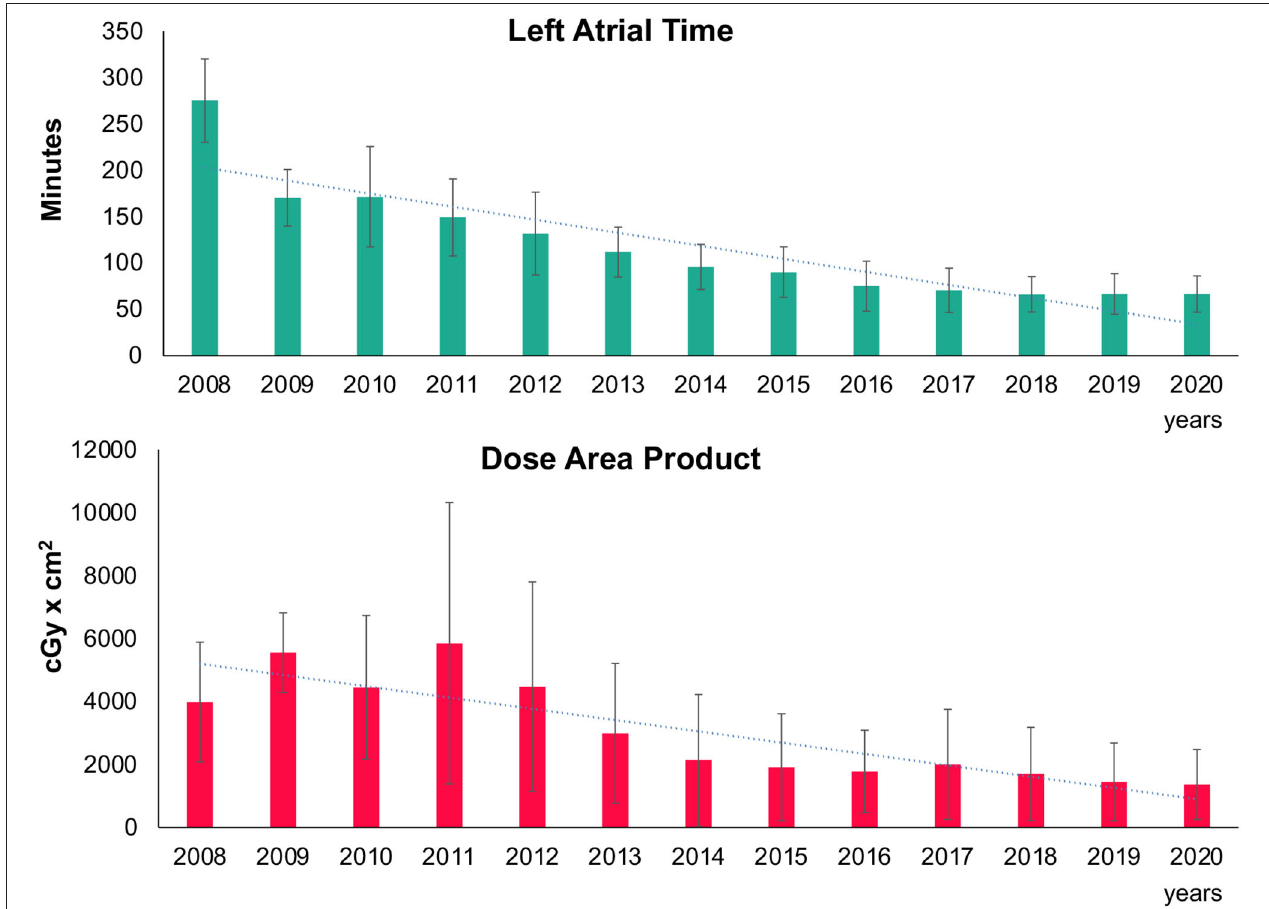
FIGURE 2 | Trend in left atrial procedure time and radiation. Mean left atrial procedure time (upper part) and dose area product (lower part) with standard deviation are depicted in bar charts over time. Trend line shows the decline over the